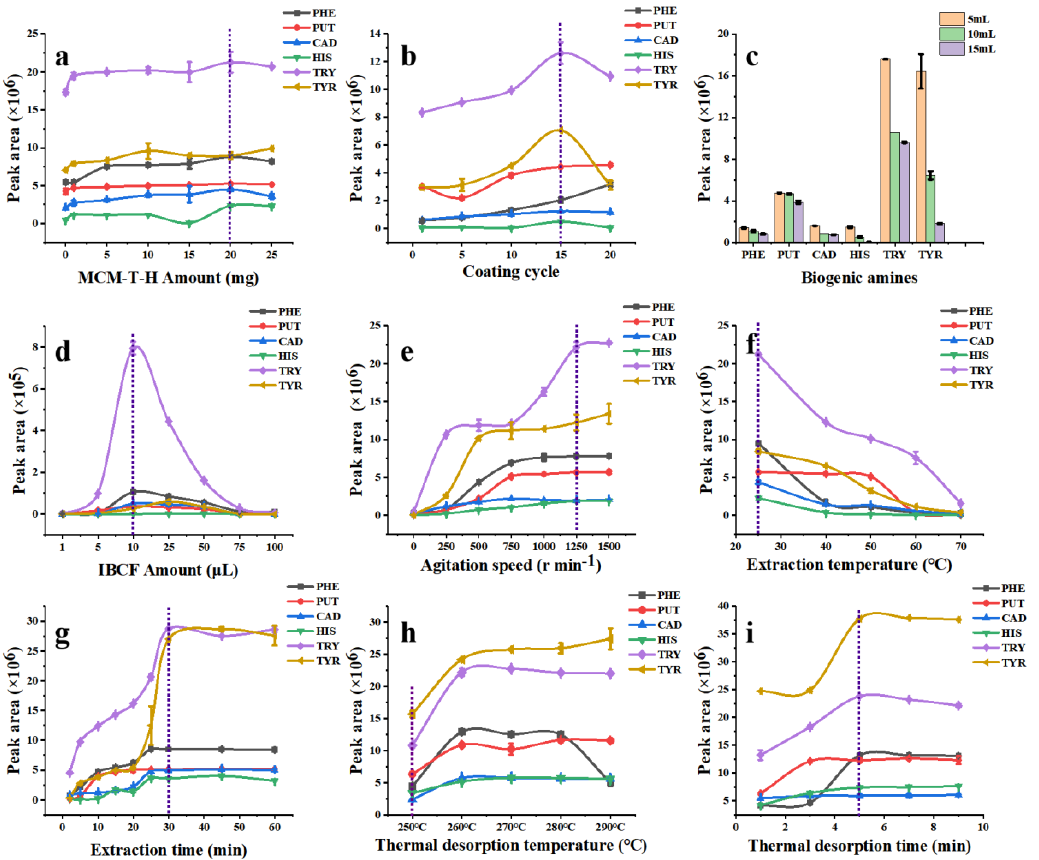
Figure 5. Optimization of SPME Arrow procedures, ( a ) MCM − T − H amount; ( b ) coating cycle; ( c ) sample volume; ( d ) derivatization reagent amount; ( e ) agitation speed; ( f ) extraction temperature; ( g ) extraction time; ( h ) thermal desorption temperature; ( i ) thermal desorption time.